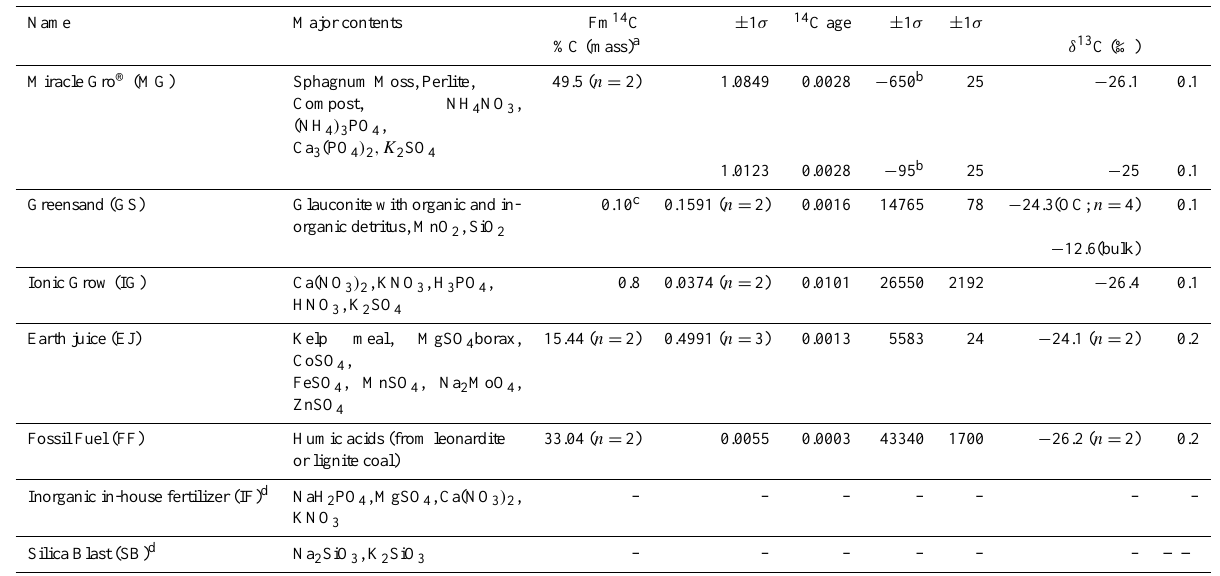
Table 1. Below-ground experiment. Details of substrate amendments, their carbon content, radiocarbon values (as Fm 14 C and 14 C age) and C isotopic signatures.